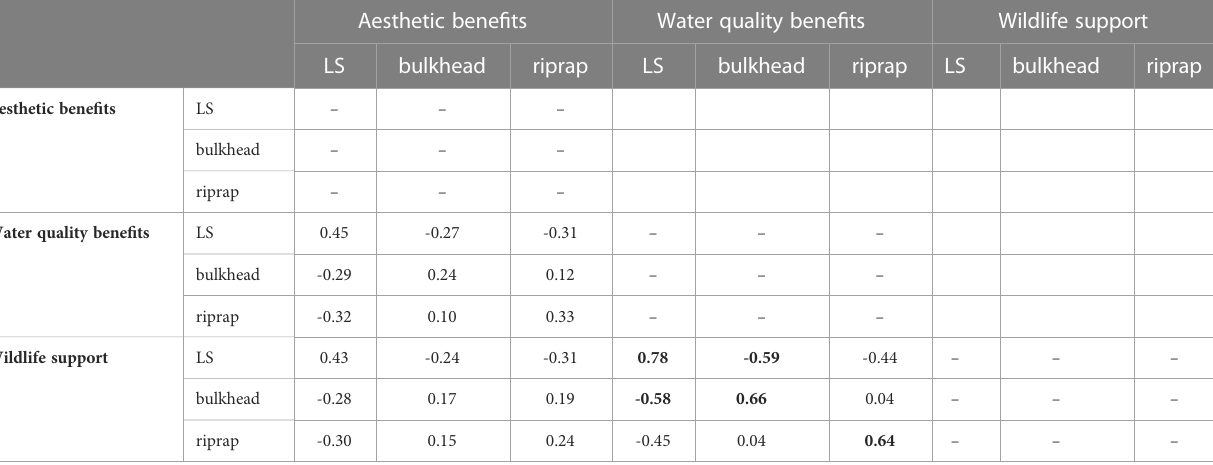
TABLE 4 Perceived ecological bene fi ts correlations.